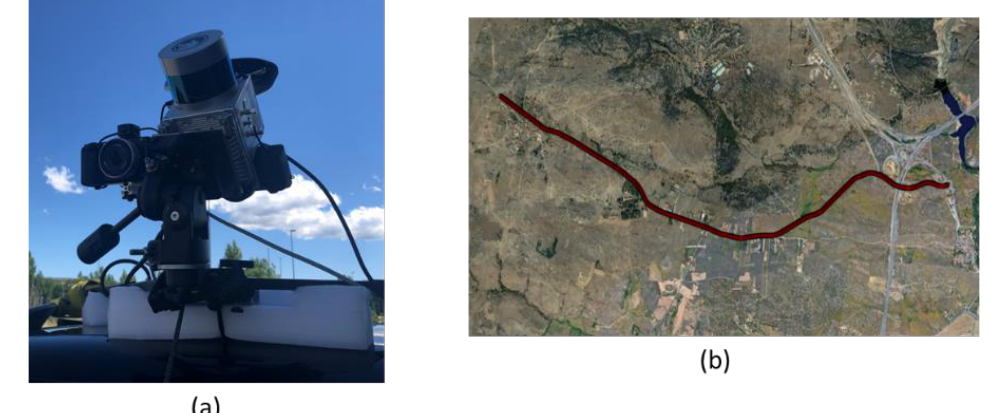
Figure 1. Case study. ( a ) low-cost mobile mapping system, with a Velodyne VLP-32C laser scanner and a manually mounted Sony A600 camera. ( b ) 6 km stretch of a regional road in the province of Á vila (Spain).